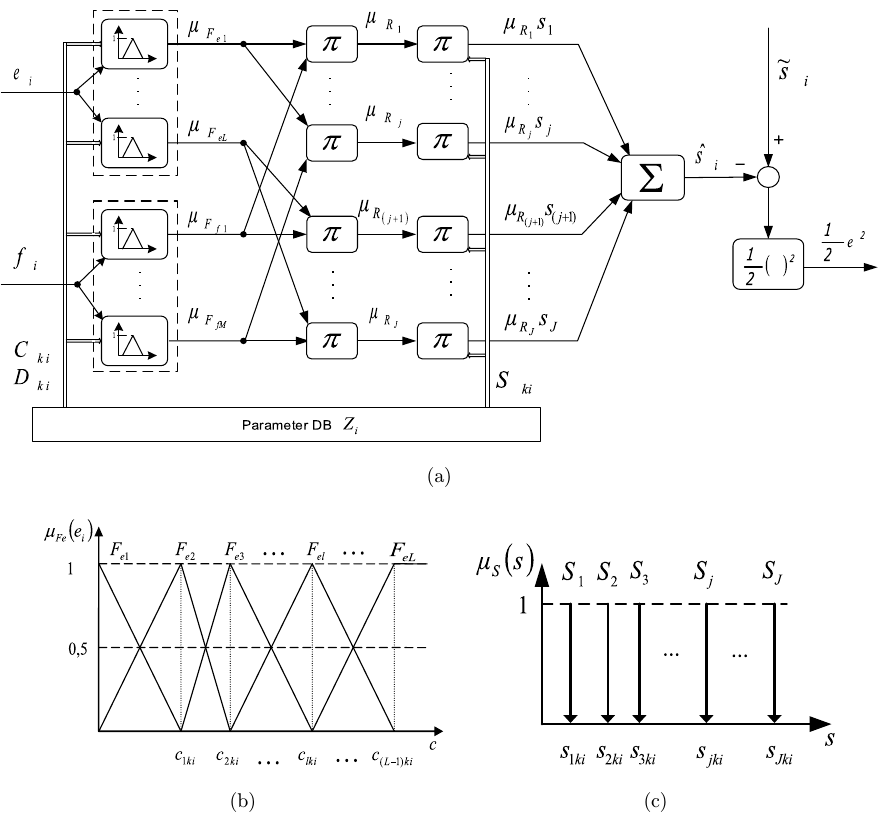
Fig. 4. Server model: (a) Neuro-fuzzy model, (b) input fuzzy sets functions and (c) output fuzzy